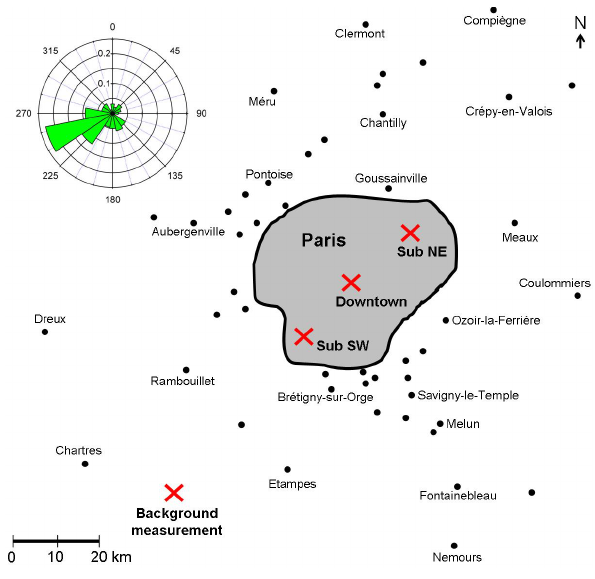
Fig. 1. Location of the stationary measurement sites (Downtown, Sub NE, Sub SW) and location of the short-time stationary back- ground measurement during the campaign using the Mobile Labo- ratory (see Sect. 3.4). The Paris agglomeration is indicated as grey area; cities outside this agglomeration are denoted as black dots for better orientation. In the upper left, the relative distribution of wind directions observed at Sub NE during the whole campaign is